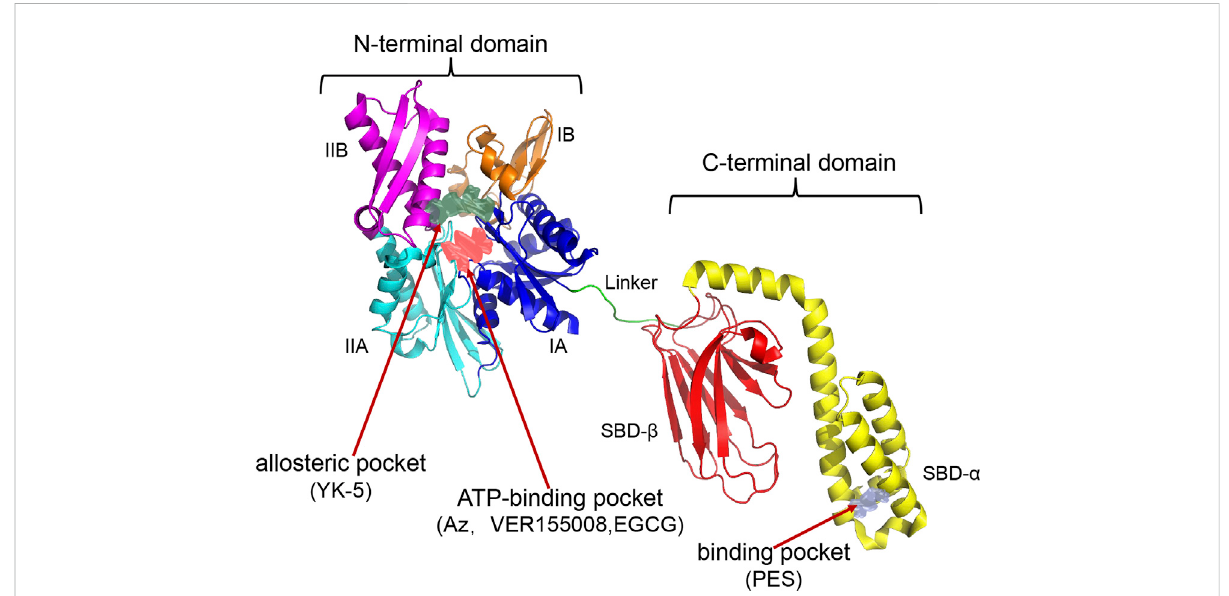
FIGURE 2 Establishment of HSP70 Homology Model and Potential Drug Sites. The following HSP70 inhibitors bind in separate pockets of HSP70: Az, VER155008, EGCG binds in the N-terminal ATP-binding pocket; YK5 binds in the N-terminal allosteric pocket (the allosteric pocket shown at the N-terminus in the fi gure is the binding site for YK-5); PES binds in the binding pocket of the C-terminal helical domain. The PDB code used to construct the homology model crystal structure is 1S3X,